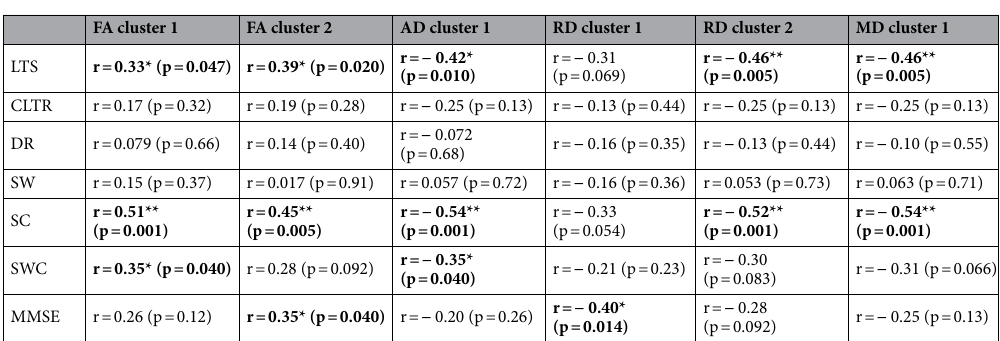
Table 4. Correlations between DTI metrics and scores of cognitive tests at all timepoints (results FDR corrected at p < 0.05). FA fractional anisotropy, AD axial diffusivity, MD mean diffusivity, RD radial diffusivity, LTS long-term storage, CLTR consistent long-term retrieval, DR delayed-recall, SW Stroop words, SC Stroop colors, SWC Stroop words/colors, MMSE Mini-Mental State Examination. Significance codes: *p < 0.05,